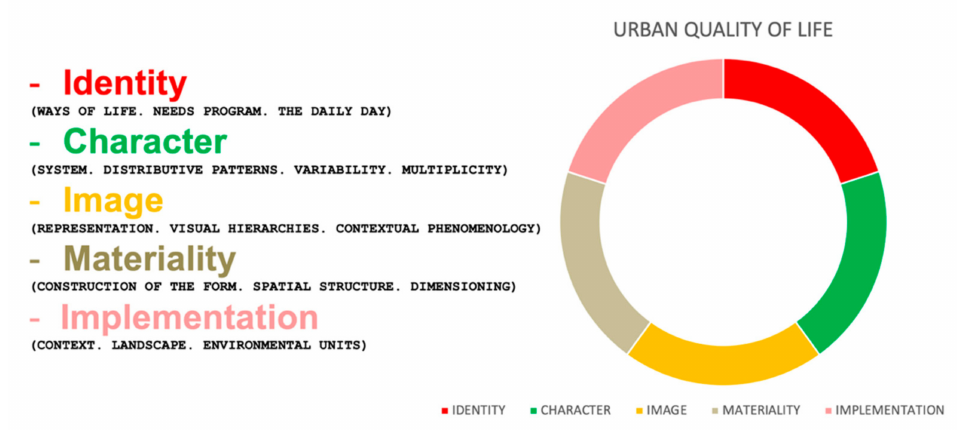
Figure 4. Key factors defining quality of life in architectural work. Source: Created by the